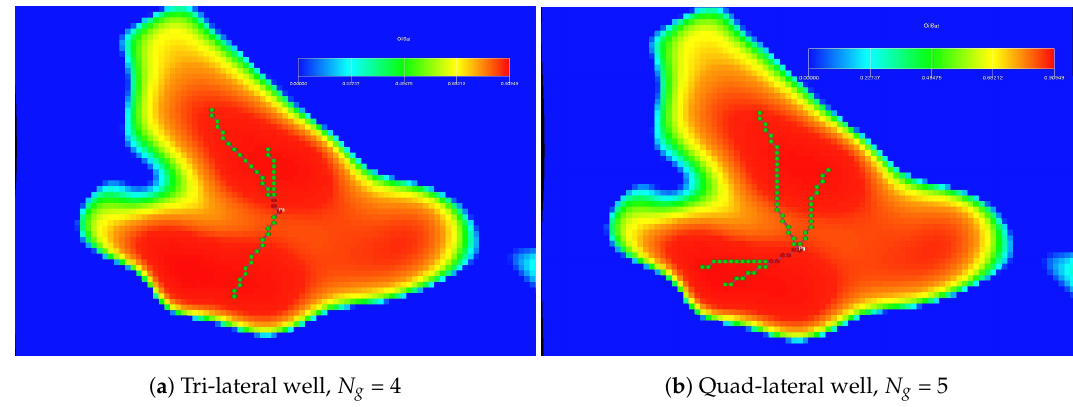
Figure 11. Examples of using the developed algorithm for generating multilateral trajectories based on the end-point